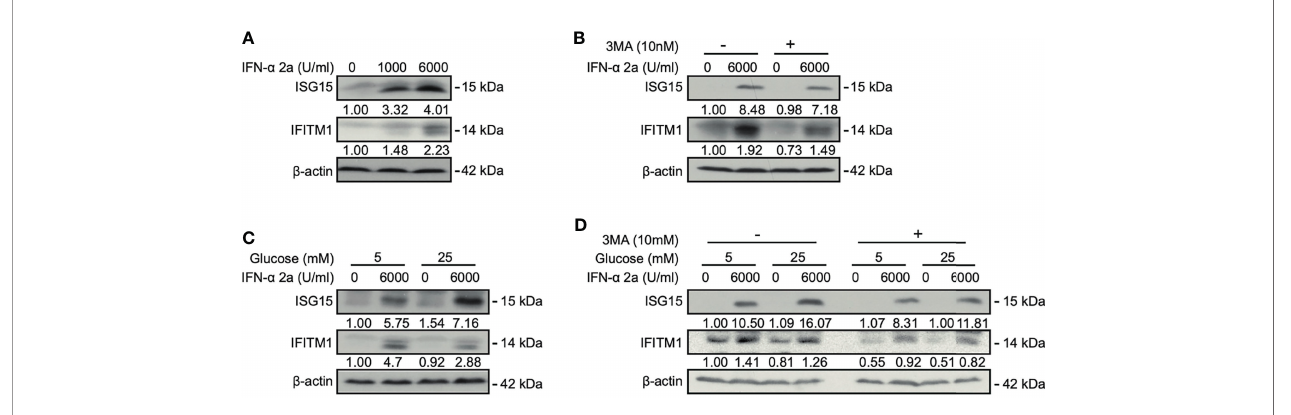
FIGURE 4 | IFN a -2a induced ISGs expression is dependent on autophagy and glucose concentrations. (A) HepG2.2.15 cells were treated with the indicated concentrations of IFN a -2a and harvested after 48 hr. (B) HepG2.2.15 cells were treated with 6000 U/ml IFN a -2a with or without 10 nM 3-MA and harvested after 48 hr. (C) HepG2.2.15 cells were cultured in medium with the indicated glucose concentrations (5 and 25 mM) with or without 6000 U/ml IFN a -2a and harvested after 48 hr. (D) HepG2.2.15 cells were cultured at the indicated glucose concentrations and 6000 U/ml IFN a -2a with or without 10 nM 3-MA. The levels of ISG15 and IFITM1 were detected by western blotting, and their relative levels were determined by quantifying the gray scales of bands, using beta ‐ actin as a loading control.